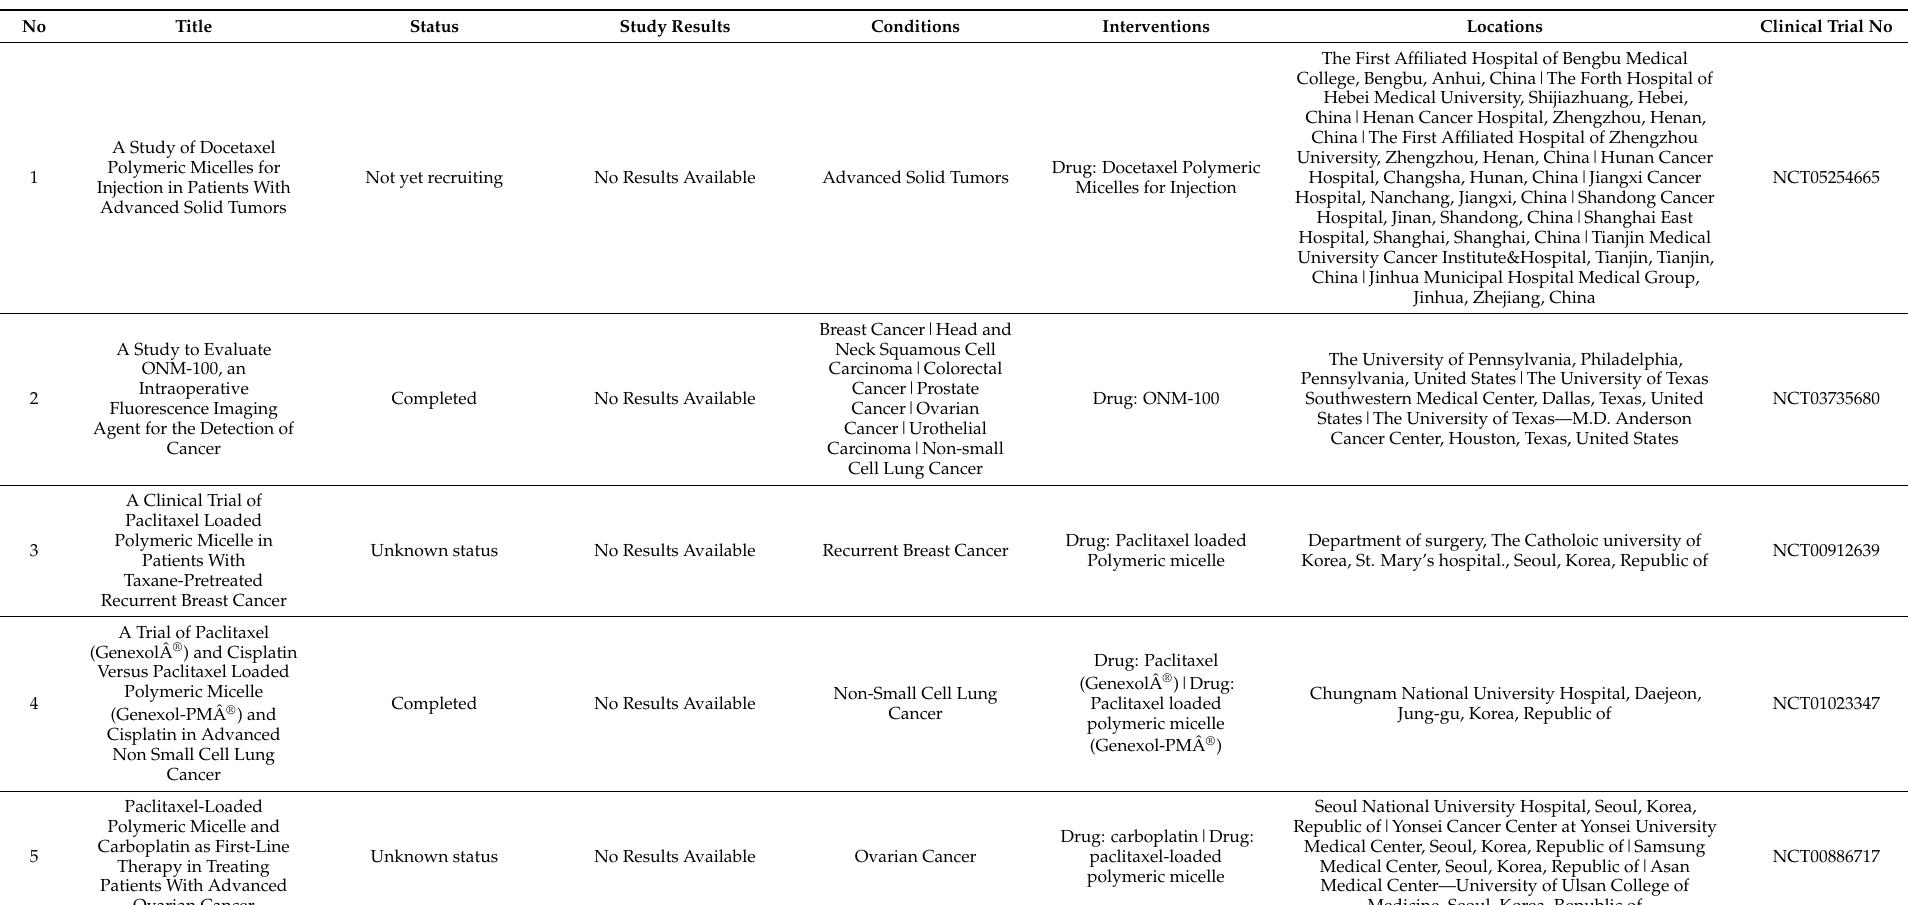
Table 2. Major clinical trials reported with polymer micelles (all the information has been obtained from the national clinical trial website: